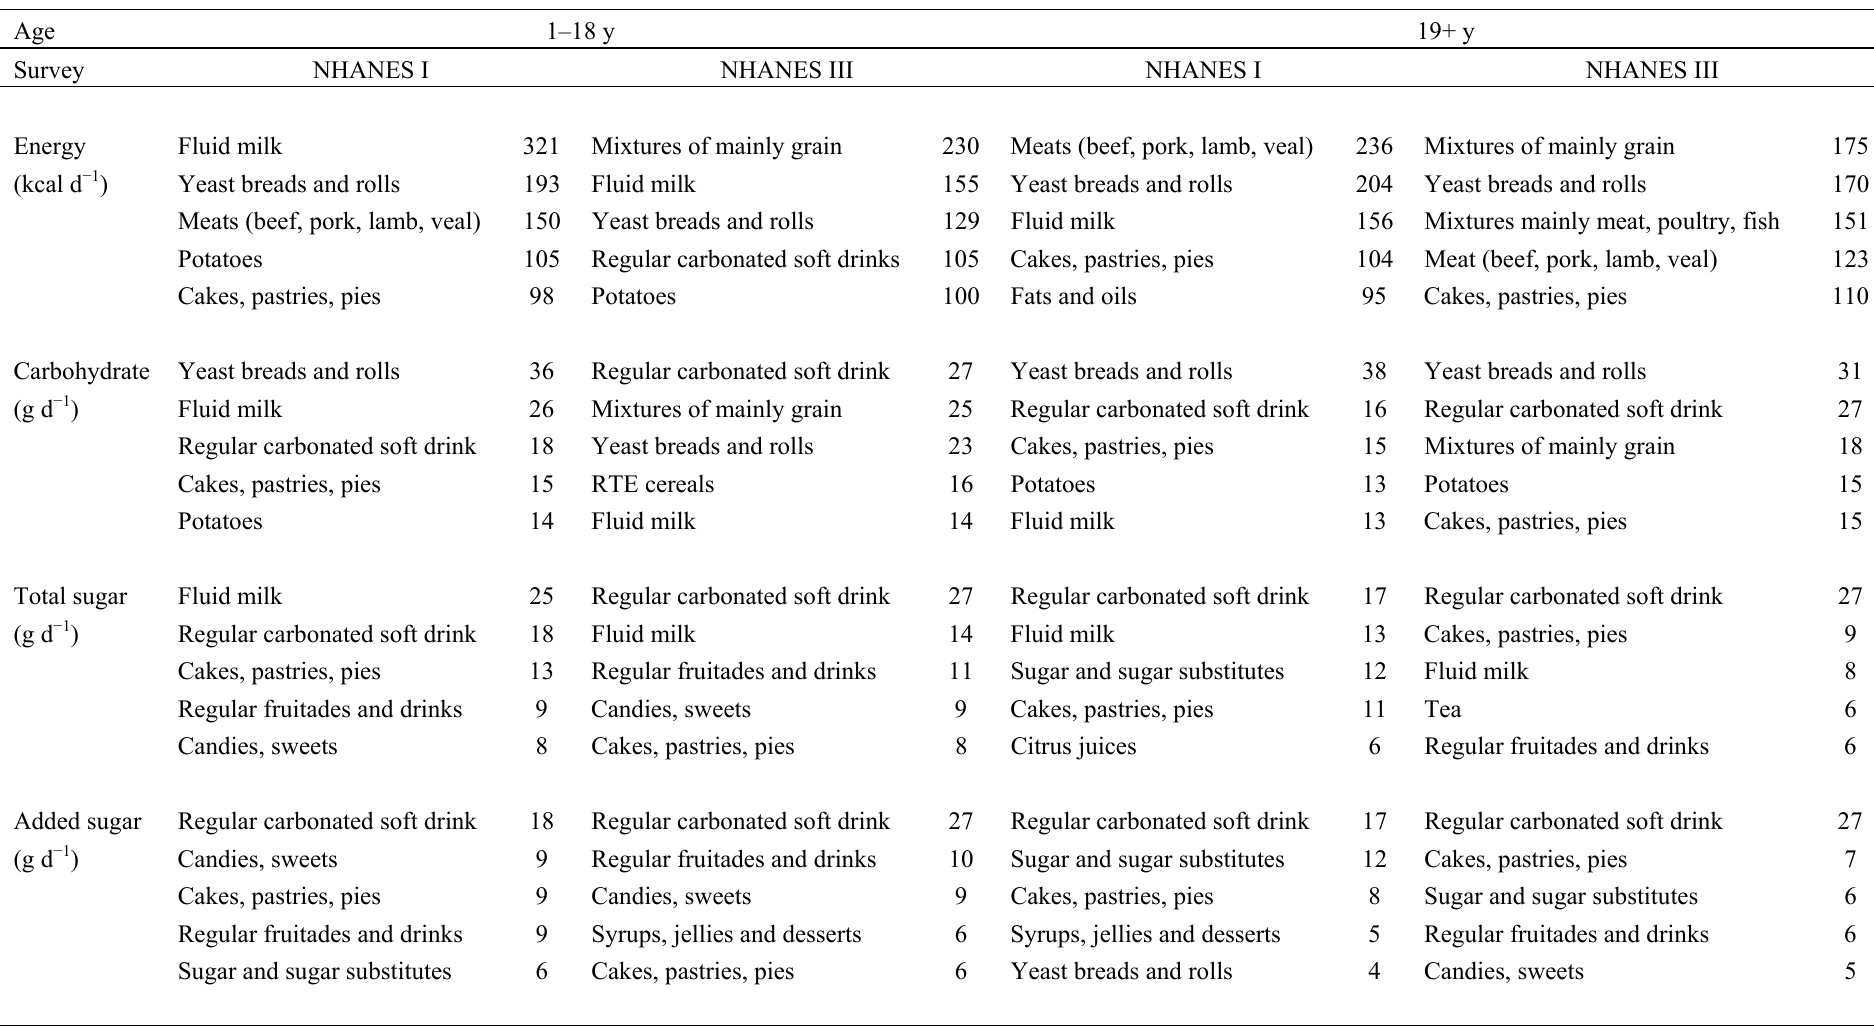
Table 4. Comparisons of food items which contribute to nutrient intake between the NHANES I and III by age subgroups. Age 1–18 y